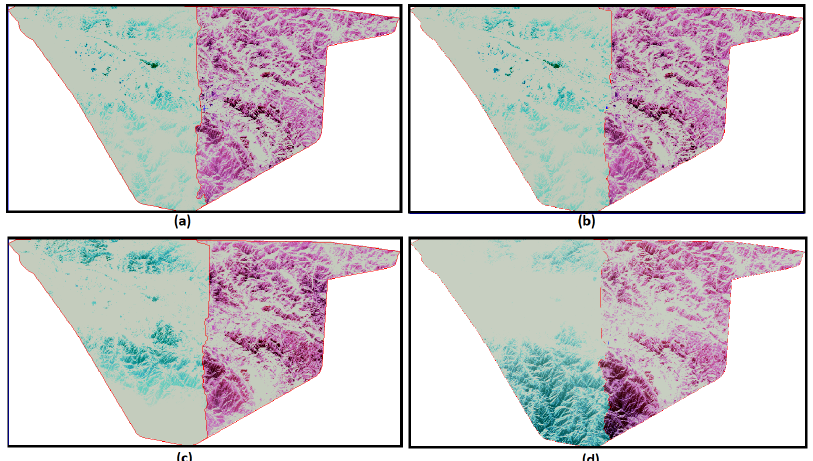
Figure 10. The color balancing outputs obtained in the South-Eastern part of the WorldView-2 tiles provided in Figure 2 using different Histogram based approaches: ( a ) minimum difference with adaptive filter, ( b ) minimum difference with hot spot, ( c ) minimum square distance with hot spot, ( d ) minimum difference with adaptive filter.